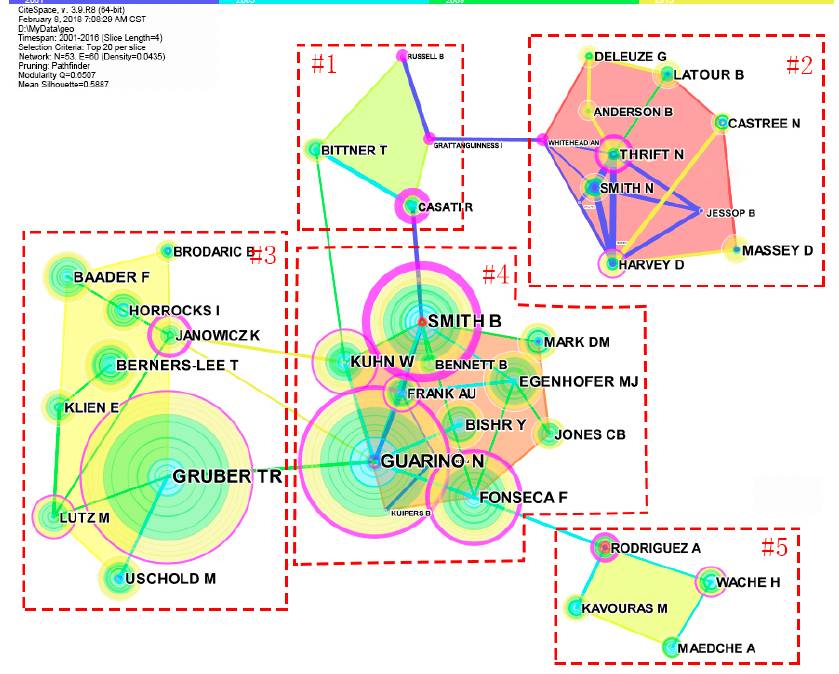
Figure 4. Cluster network of author co ‐ citations for 53 documents and 60 links.